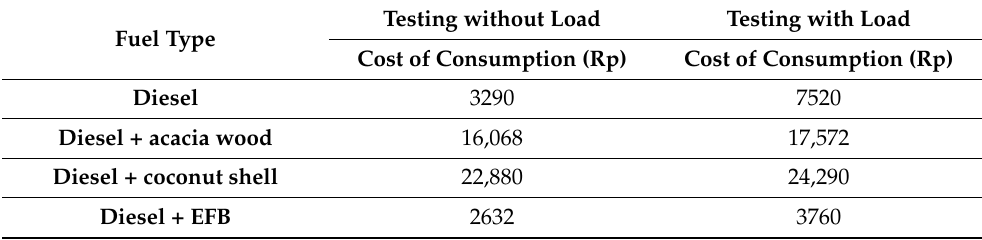
Table 3. Comparison of fuel consumption